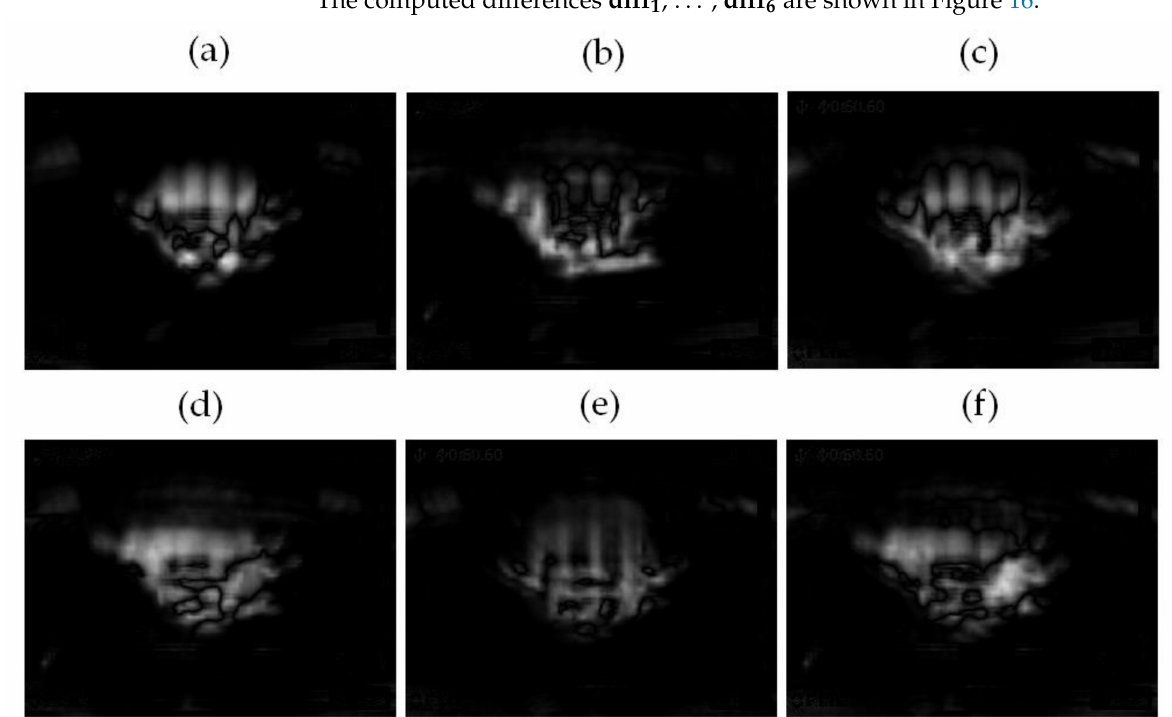
Figure 16. Computed difference: ( a ) diff 1 = | class 1 − class 2 |, ( b ) diff 2 = | class 1 − class 3 |, ( c ) diff 3 = | class 1 − class 4 |. Computed difference: ( d ) diff 4 = | class 2 − class 3 |, ( e ) diff 5 = | class 2 − class 4 |, ( f ) diff 6 = | class 3 − class 4 |. The obtained matrix sum_avg is presented in Figure